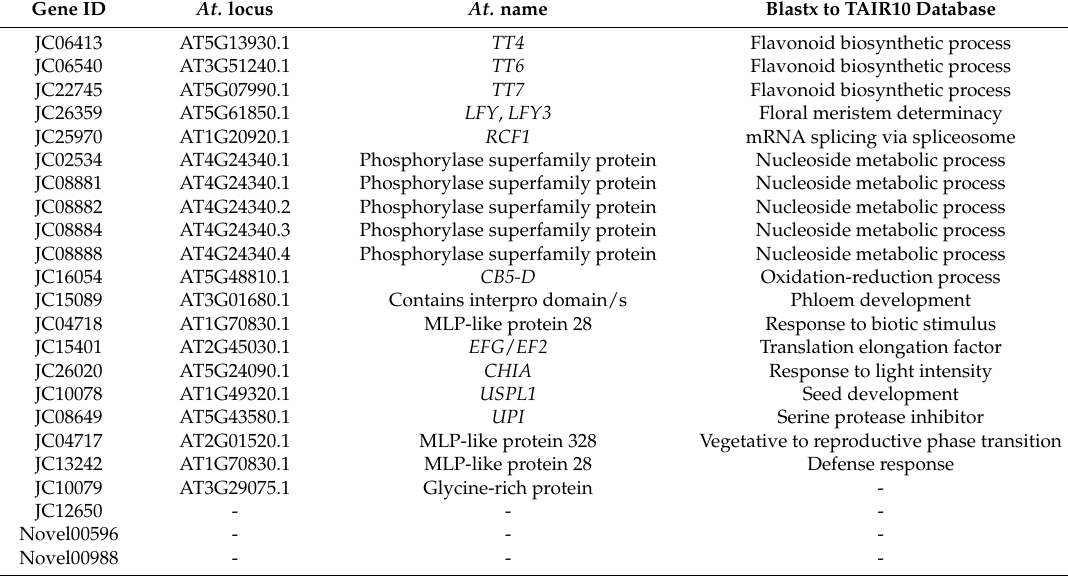
Figure 5. In figure body the DEGs analysis of different time points after GA 3 treatment in J. curcas . ( a ) venny diagram of the DEGs detected in each comparison; ( b ) the heat-map of the DEGs co-detected in all of the comparisons, the color was involved in the log 2 (Fold change) of DEGs in different comparison, red was upregulation and green is downregulation. In addition, TC6: T6 vs. CK6, TC12: T12 vs. CK12, TC24: T24 vs. CK24, TC48: T48 vs. CK48, and the same below. Table 1. The annotation of the 23 DEGs co-detected in the four comparisons after GA 3 treatment. At.